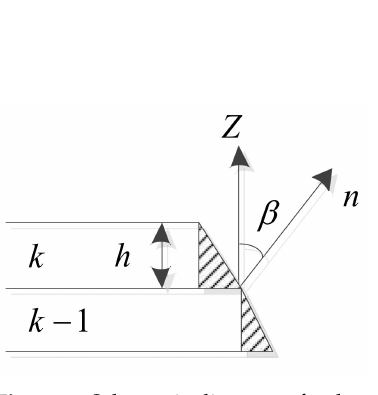
Figure 2. Schematic diagram of volume error.